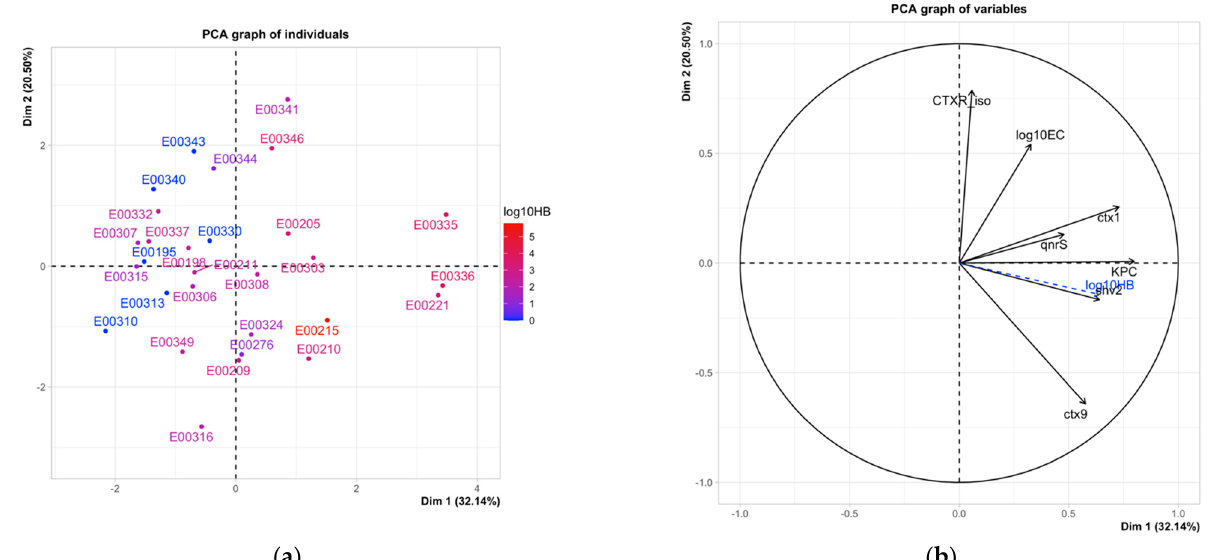
Figure 3. Principal component analysis of environmental sites using the input variables using per- cent of CTX isolates, the presence of specific resistance genes, and E. coli concentrations (log10EC). ( a ) Ordination of sites by the two principal component axes. Sites are shaded by the log10 concen- tration of HB. ( b ) Impact of variables on sample ordination. Variables shown in black were used in the analysis; log10 HB (in blue) was supplementary.